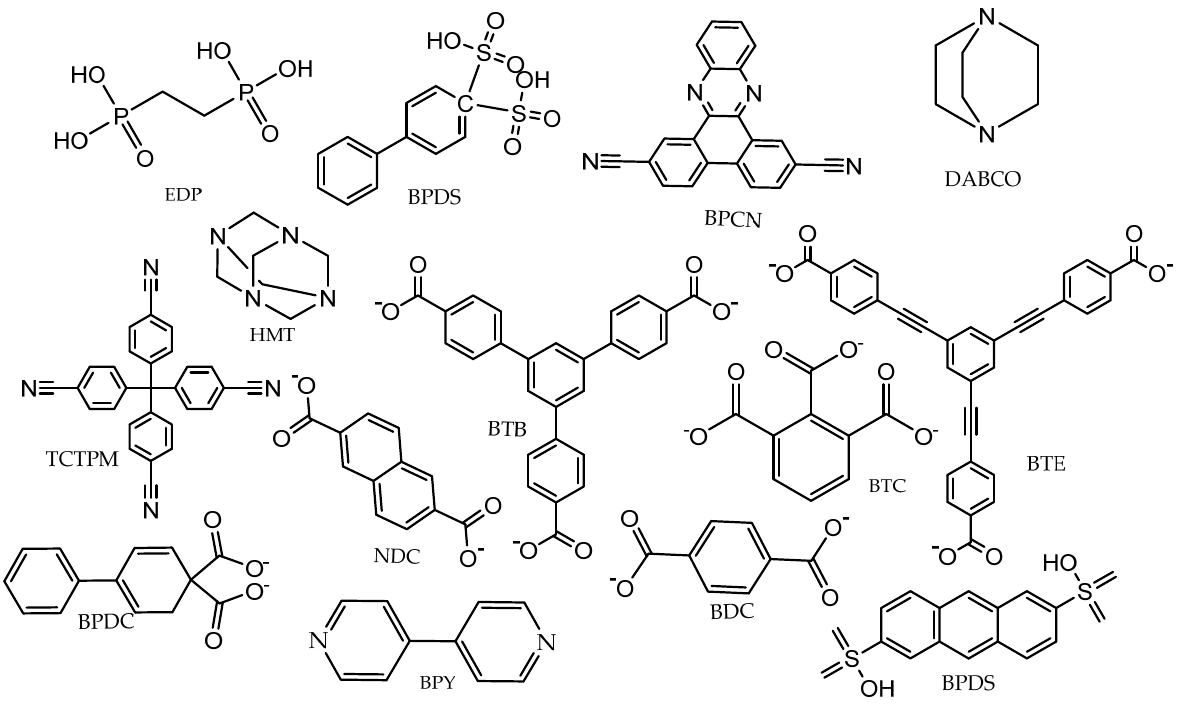
Figure 6. Typical ligands used for MOF synthesis.